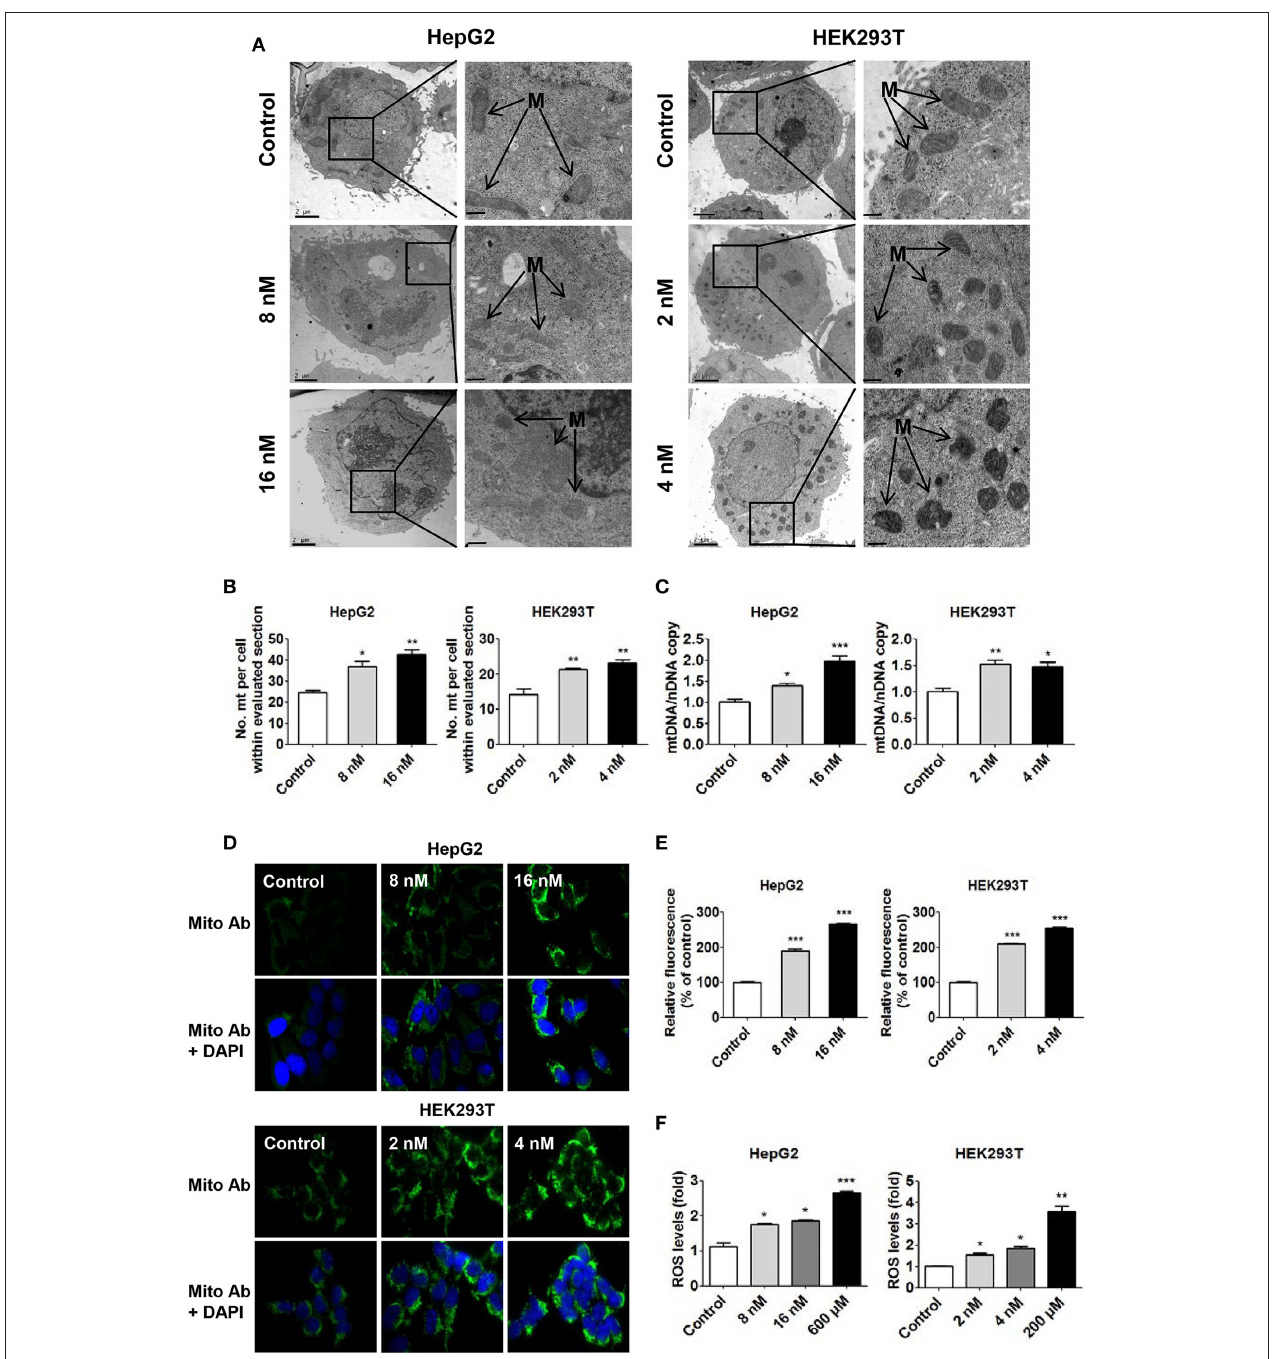
FIGURE 2 | Increased mitochondrial biogenesis and ROS production in HepG2 and HEK293T cells in response to T-2 toxin treatment. (A) Representative transmission electron microscopy images of HepG2 and HEK293T cells treated with T-2 toxin. M indicates mitochondria. Scale bars: left panel, 2 µ m; right panel, 1 µ m. (B) Quantification of the number of mitochondria per cell in the imaged section (control, n = 35 cells; T-2 toxin treated, n = 35 cells). (C) Mitochondrial DNA content in HepG2 and HEK293T cells treated with T-2 toxin, analyzed by RT-qPCR. The primers used in this quantification are listed in section Materials and Methods. (D) Mitochondrial mass analysis by immunostaining. Mitochondrial staining (green) is shown in the top panels. To quantify the mitochondrial mass, treated cells were fixed and immunostained with anti-intact mitochondrial membrane antibody. Mitochondrial staining (green) and DAPI (blue) are shown in the bottom panels. Original magnification, 100 × . The detailed measurement procedure is described in the section Materials and Methods. The fluorescence images for the GFP channel and the DAPI channel were taken with the same settings and exposure time. (E) Quantitative analysis of fluorescence intensity (mitochondrial staining) for HepG2 and HEK293T cells treated with T-2 toxin. Twenty-five images were analyzed for each count. (F) Detection of ROS generation in HepG2 and HEK293T cells treated with T-2 toxin and H 2 O 2 stained with carboxy-H2DCFDA for 30min at 37 ◦ C. Statistically significant differences are indicated by asterisks (* P < 0.05, ** P < 0.01, *** P < 0.001).